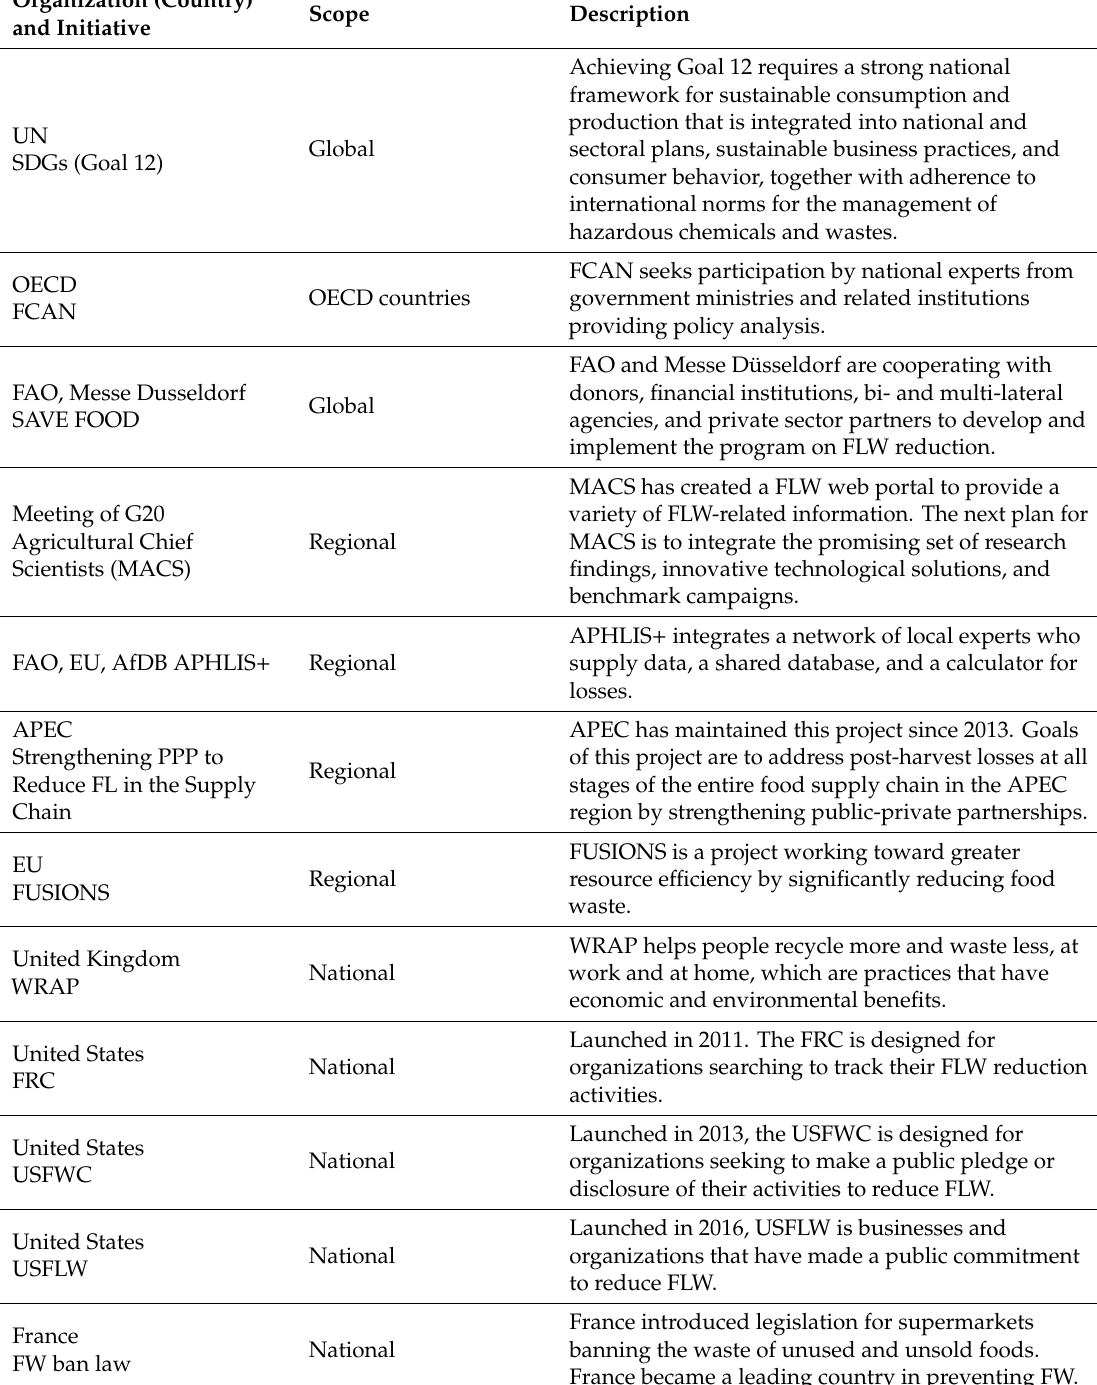
Table 11. Summarize of leading e ff